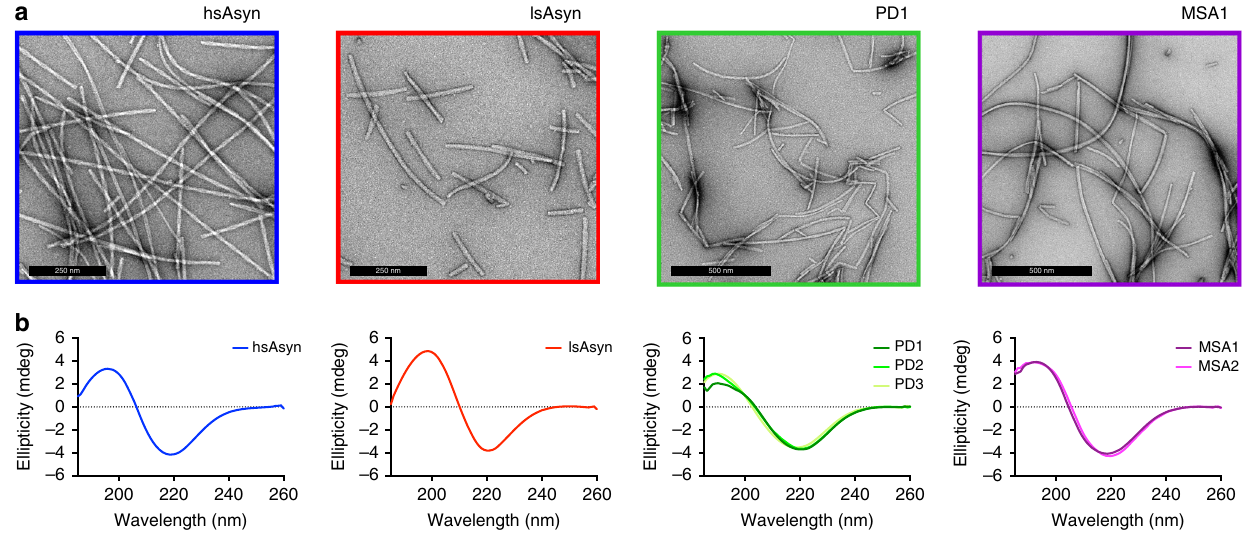
Fig. 2 Electron micrographs and circular dichroism spectra of aSyn fi brils. a Electron micrographs of the two in vitro polymorphs hsAsyn (blue) and lsAsyn (red), as well aSyn fi brils ampli fi ed from brain extracts of a PD (green) and a MSA patient (purple; Table 1). b Circular dichroism spectra of aSyn fi